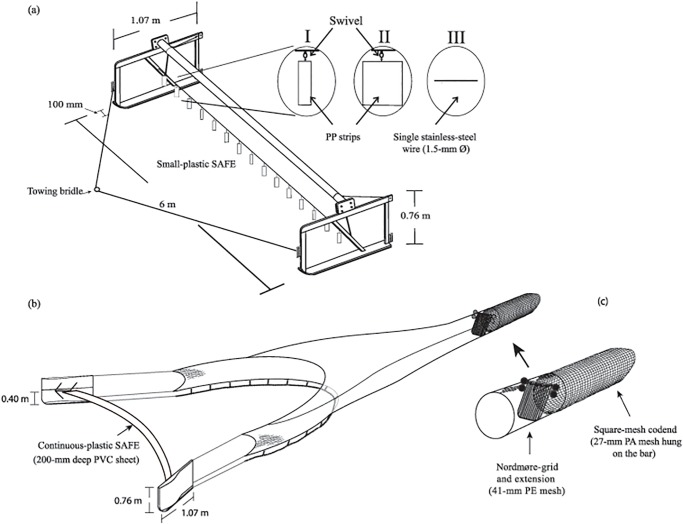
Schematic representation of the (a) beam trawl showing towing bridle and attachment locations of the (I) small-plastic (polypropylene–PP) (60 × 200 × 1 mm), (II) large-plastic (PP) (200 × 200 × 1 mm) and (III) the single-wire (1.50-mm Ø stainless steel) simple anterior fish excluders (SAFEs) tested in experiment 1 and (b) otter trawl with the polyvinyl chloride (PVC) continuous-plastic SAFE tested in experiment 2. The extension (with Nordmøre-grid) and codend (c), used in both experiments, are highlighted. PA, polyamide; PE, polyethylene.